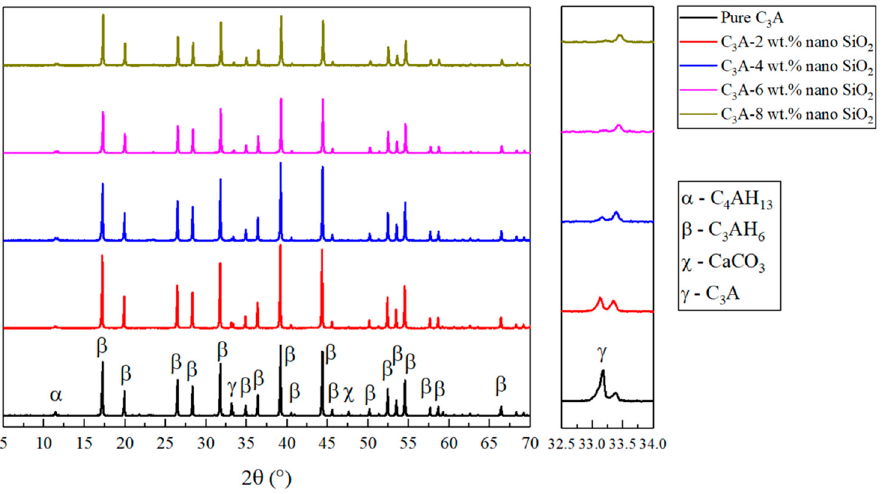
Figure 2. XRD analysis of all the samples to observe the evolution of peaks related to the hydra- tion of the